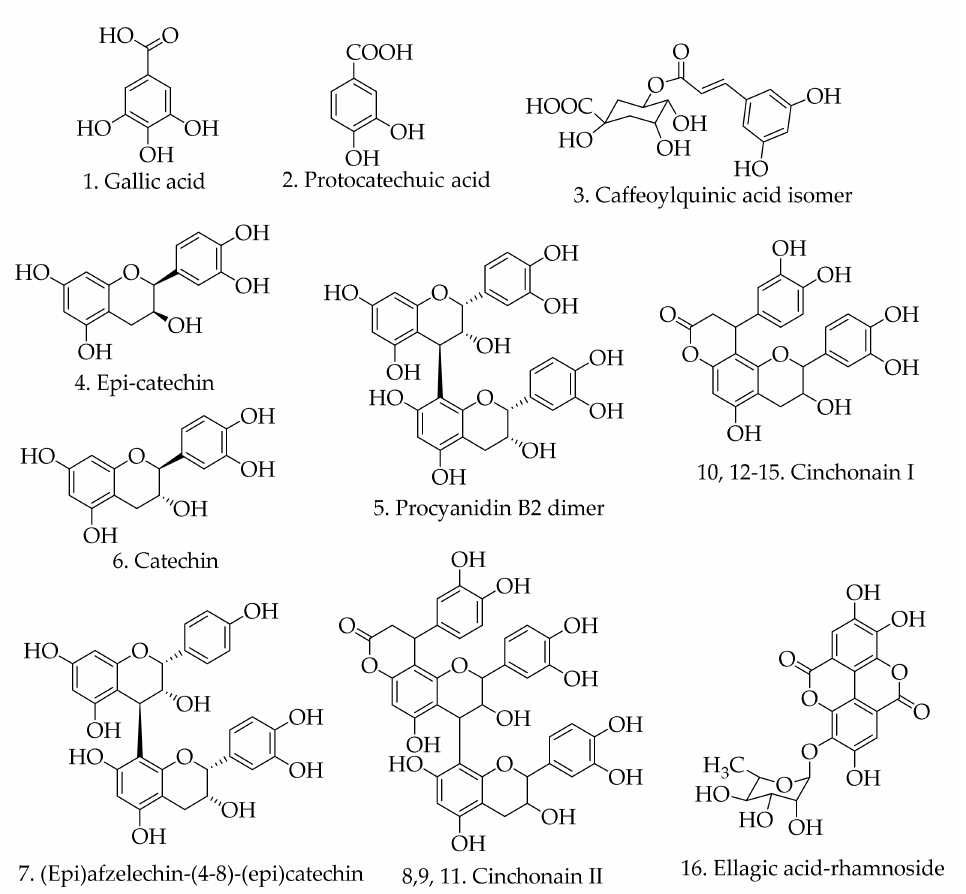
Figure 6. Structures of constituents tentatively identified in the EA fraction of Ficus glumosa stem